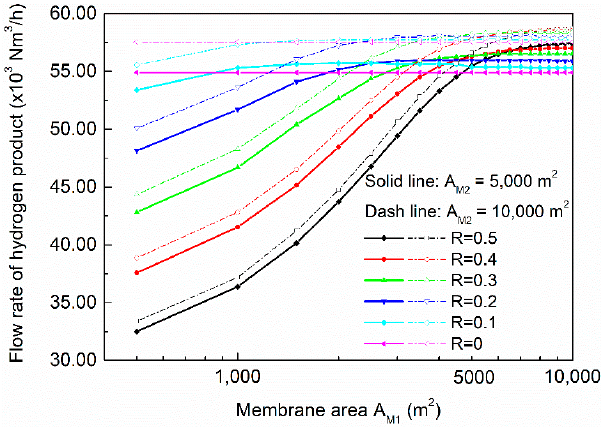
Figure 11. Effects of membrane area and syngas cut ratio on product flow rate of hydrogen.